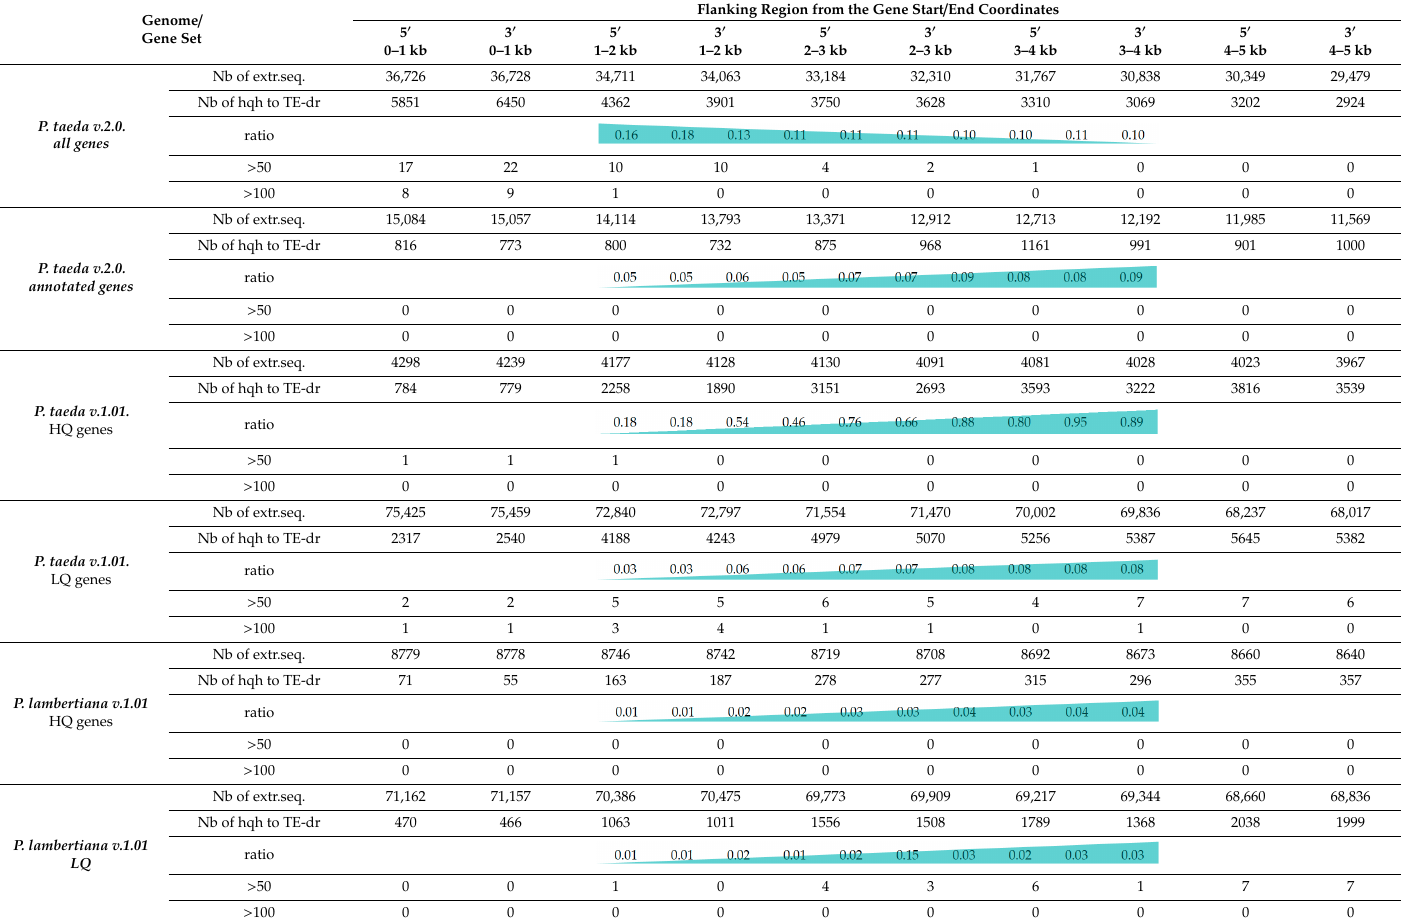
Table 1. Comparison of extracted gene-flanking regions in genome data sets. Genome/ Gene Set Flanking Region from the Gene Start/End Coordinates 5 ′